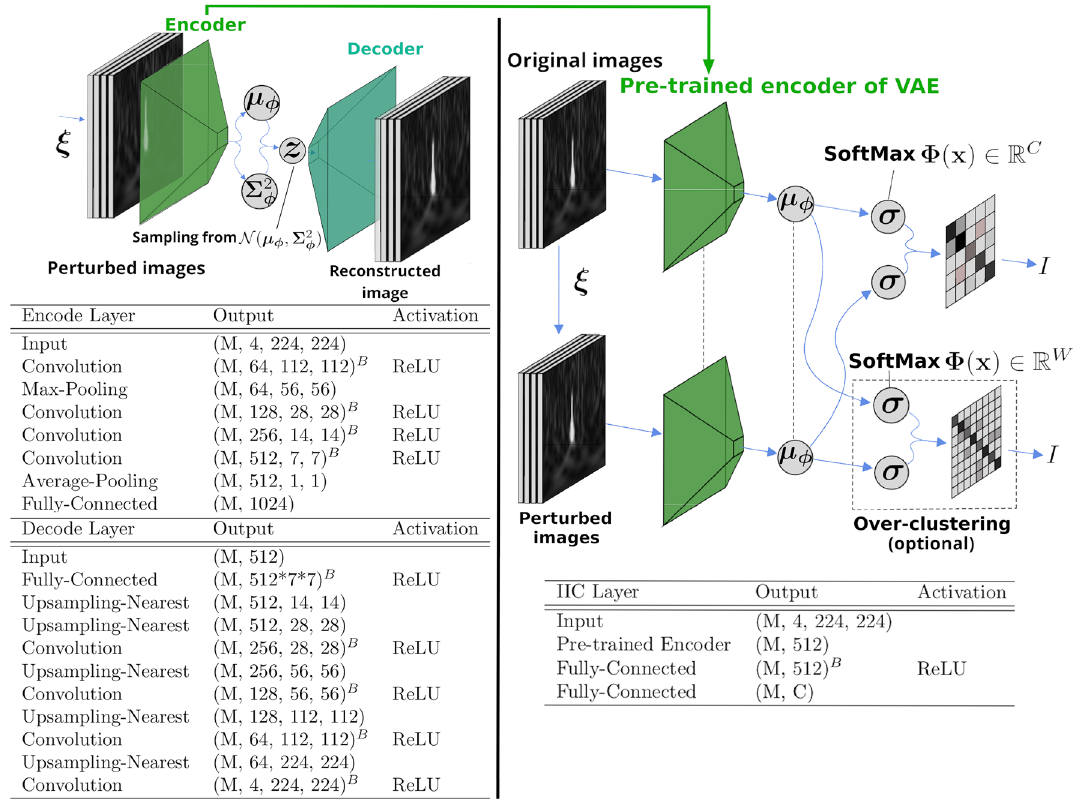
Figure 8. Proposed architecture for the classification of transient noise. The tables show the details of the B architectures of neural networks. denotes batch-normalise to an object, and M denotes the mini-batch size. Left: Schematic architecture of the VAE for feature learning. The VAE trains neural networks to maximise the lower bound in (3). The input to the VAE is a perturbed image x ′ of the time–frequency spectrogram of the transient noise. This pre-process allows the encoder to learn features that do not depend on the perturbation. At the output layer of the encoder, the average and variance of the feature variable z are output from the same network and separated into the dimensions (M, 512). Subsequently, the feature variables z are constructed using the reparameterisation trick . The decoder uses z to generate a reconstructed image that is close to the input image. Right: Schematic architecture of the IIC for classification. The IIC trains neural networks to maximise the mutual information between the input data and its perturbed data. The inputs to the pre-trained encoders of the VAE are the original and perturbed images, respectively. Both encoders have the same architecture, and the dashed lines indicate the sharing weights of the neural networks in the figure. The IIC classifies transient noise using the SoftMax activation function at the output layer from the feature, which is the output of the pre-trained encoder. C is the estimated number of classes of the transient noise, and W is the number of classes used in the